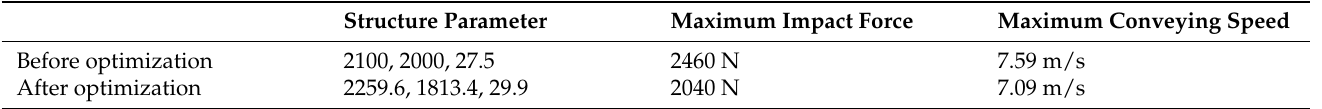
Table 7. Result comparisons of the chute structure before and after optimization. Structure